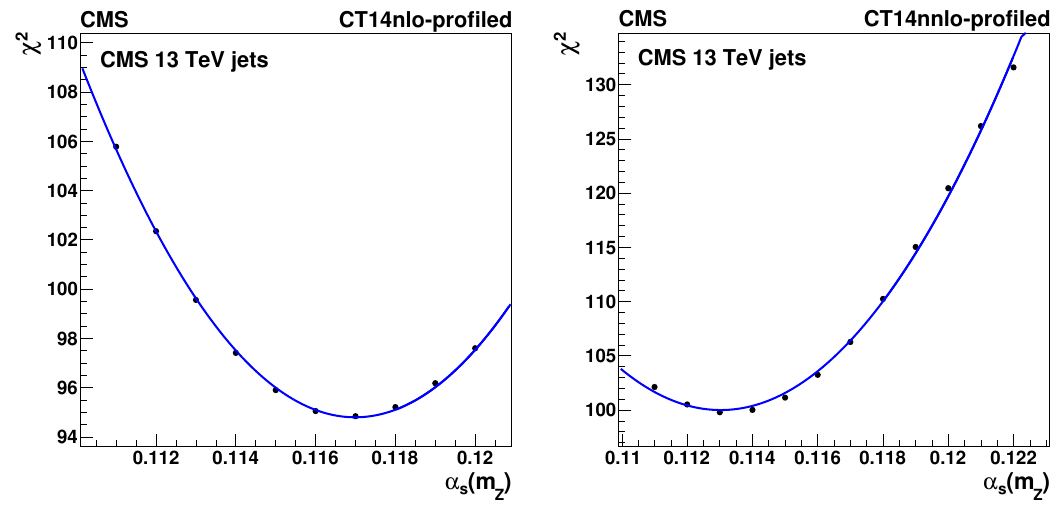
( m ) series using the CMS inclusive jet S Z